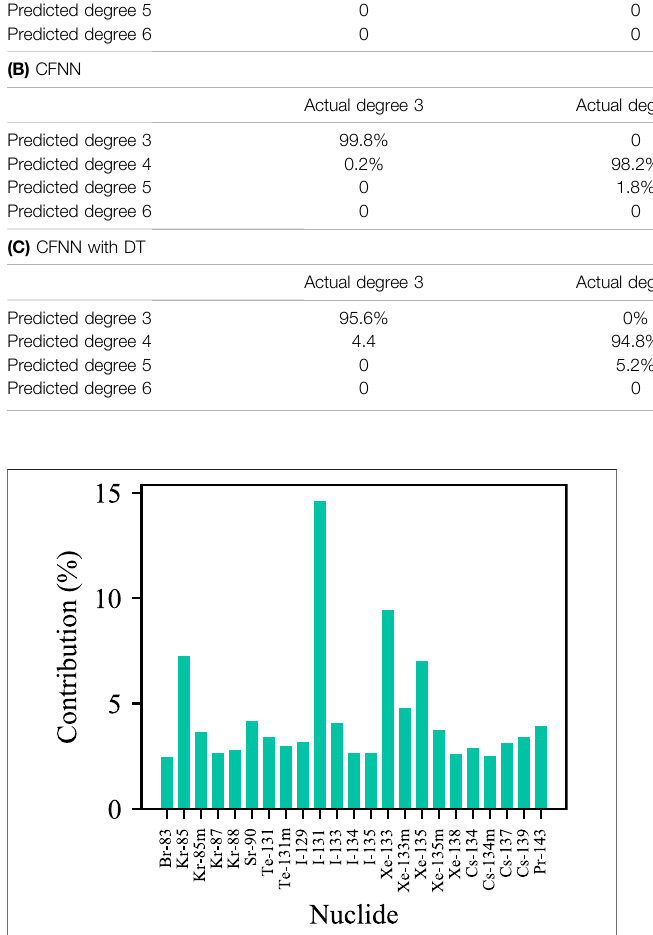
FIGURE 8 | Contribution of FPs to the output of the neural network.